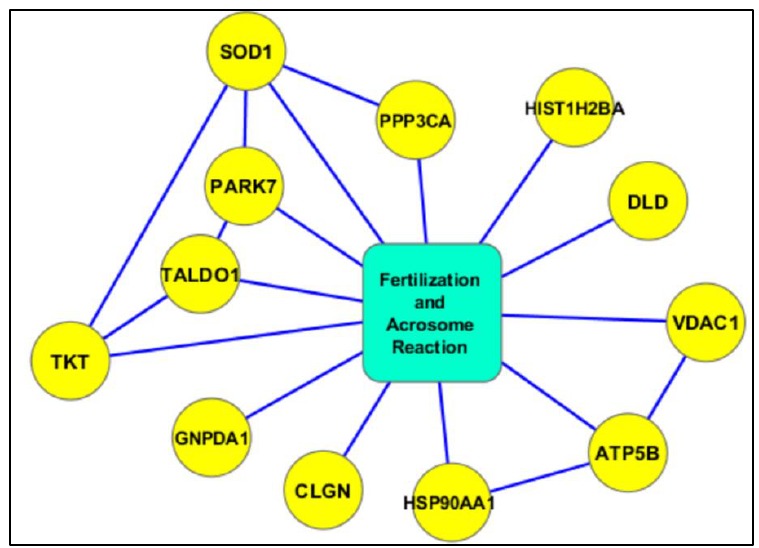
Figure 5. Interaction network of acetylated proteins associated with fertilization and the acrosome reaction.